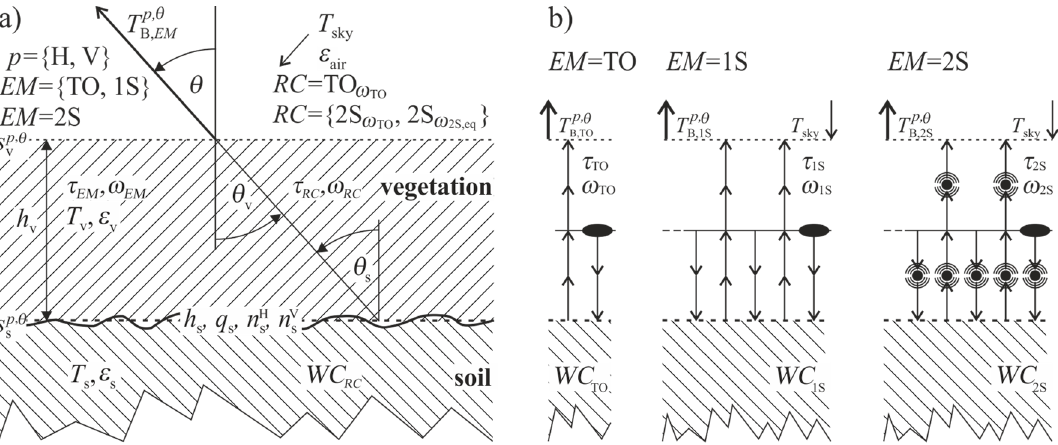
Figure 1. ( a ) Setup of the Emission Models EM = { TO,1S, 2S } used to simulate L-band T p , θ rough soil surface covered by a vegetation layer. Symbols are explained in the text. ( b ) Sketches of how the 0 th -order EM = { TO,1S } and the 1 st -order EM = 2S represent downwelling radiation emitted by a volume of vegetation (solid ellipse).